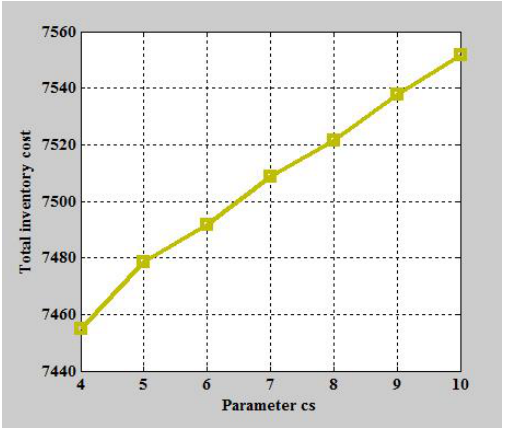
Fig 6: Sensitivity: parameter c s v/s